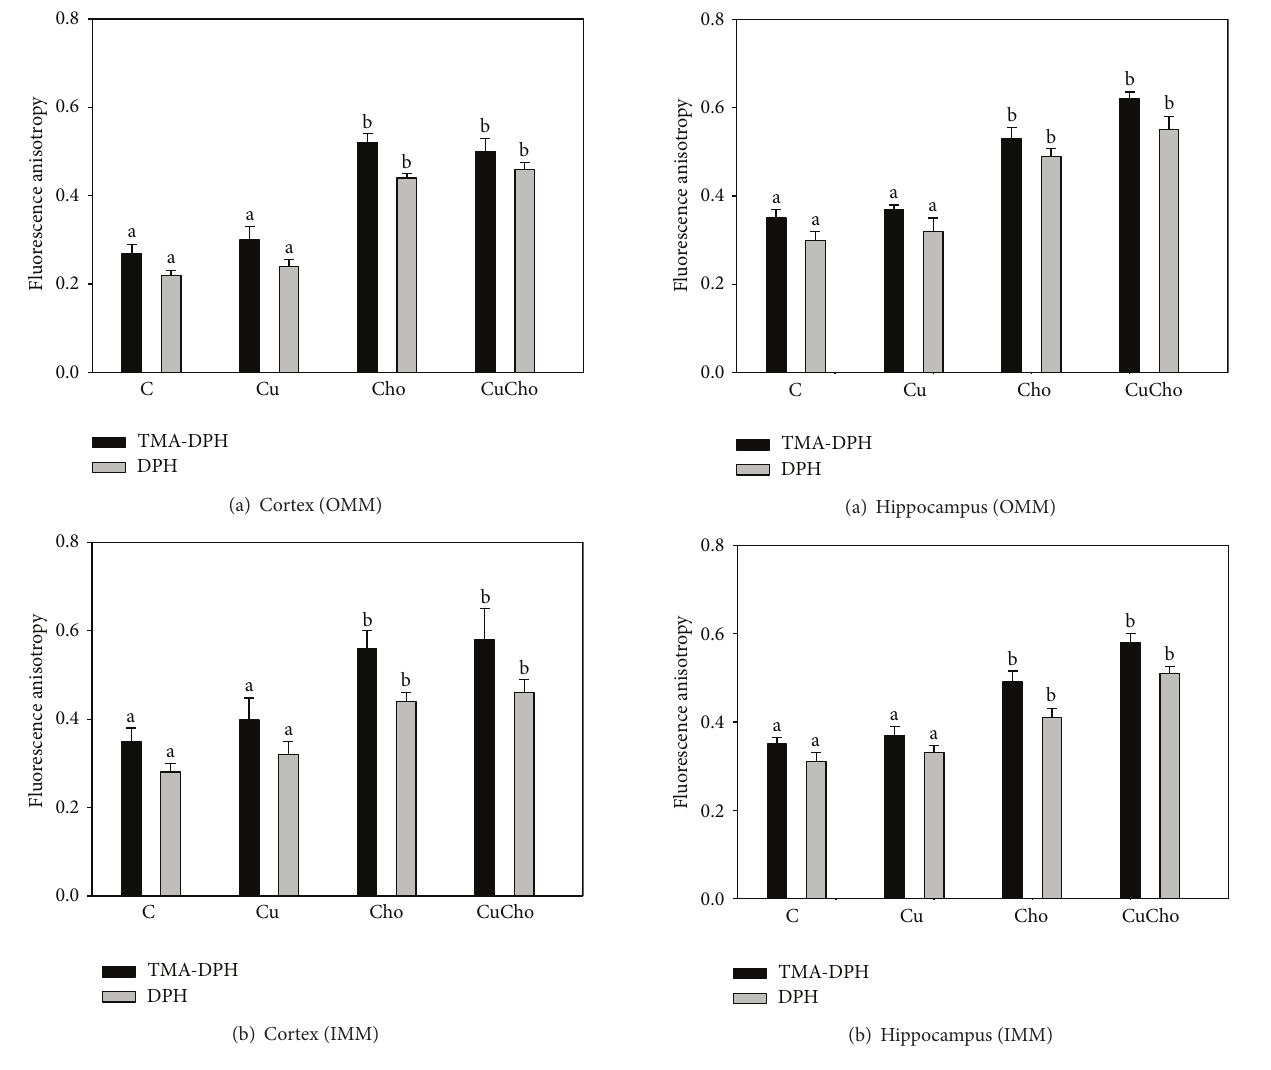
Figure8:Mitochondrialouter(a)andinner(b)membranefluidities (fluorescence anisotropy) in suspension isolated from brain hip- pocampus. Treatments are indicated with different colors, control (whitebars),Cu(blackbars),Cho(graybars),andCuCho(darkgray bars). Samples were analyzed as indicated in Section 2.9. Results are expressed as the mean ± standard deviation (SD) of 10 rats. Significant differences among the experimental groups are indicated with superscript letters (values with distinct letters are significantly different between them, 𝑃 < 0.01